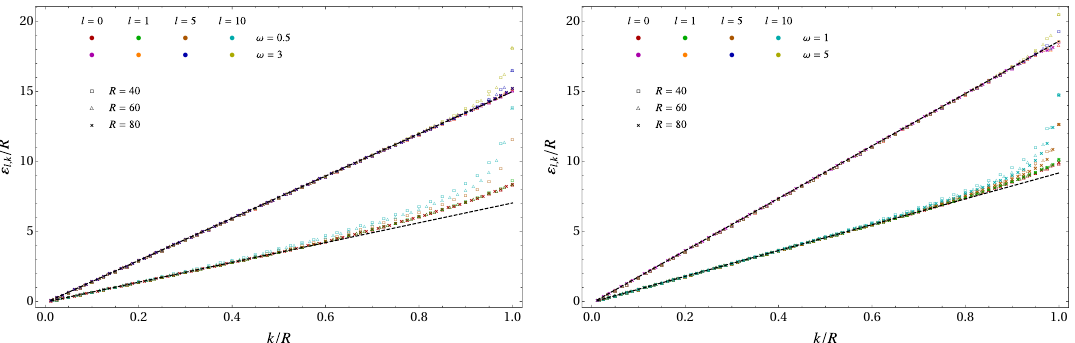
Figure 10. Single particle entanglement energies at fixed l for d = 3 and ω ∈ { 0 . 5 , 1 , 3 , 5 } . The dashed lines correspond to